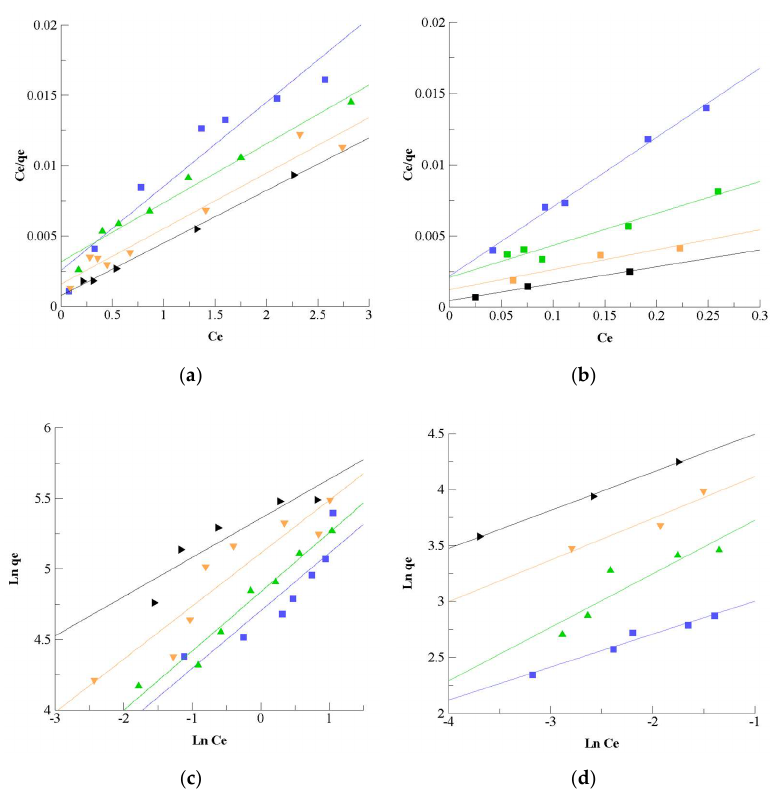
Figure 8. Application of Langmuir and Freundlich models to experimental glucosinolates adsorption (PA312LOH resin) data at ( ■ ) 20 °C, ( ▲ ) 30 °C, ( ▼ ) 40 °C and ( ► ) 60 °C: ( a ) application of Langmuir model for sinigrin adsorption data; ( b ) application of Langmuir model for gluconapin adsorption data; ( c ) application of Freundlich model for sinigrin adsorption data and ( d ) application of Freundlich model for gluconapin adsorption data.